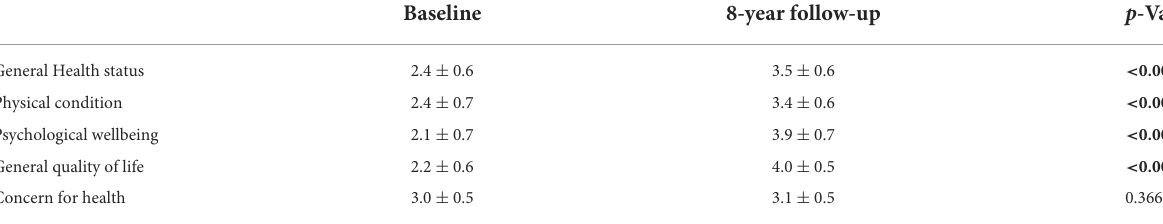
TABLE 5 Self-assessment of general health and wellbeing at the baseline and in follow-up